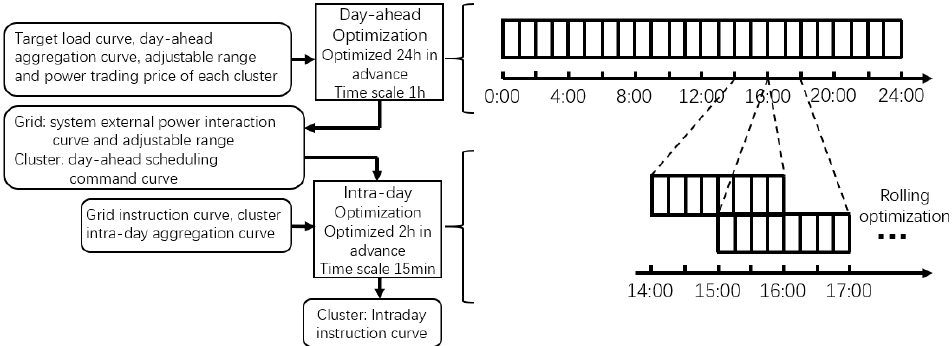
Figure 2. Framework of multi ‐ timescale optimization method for clusters.